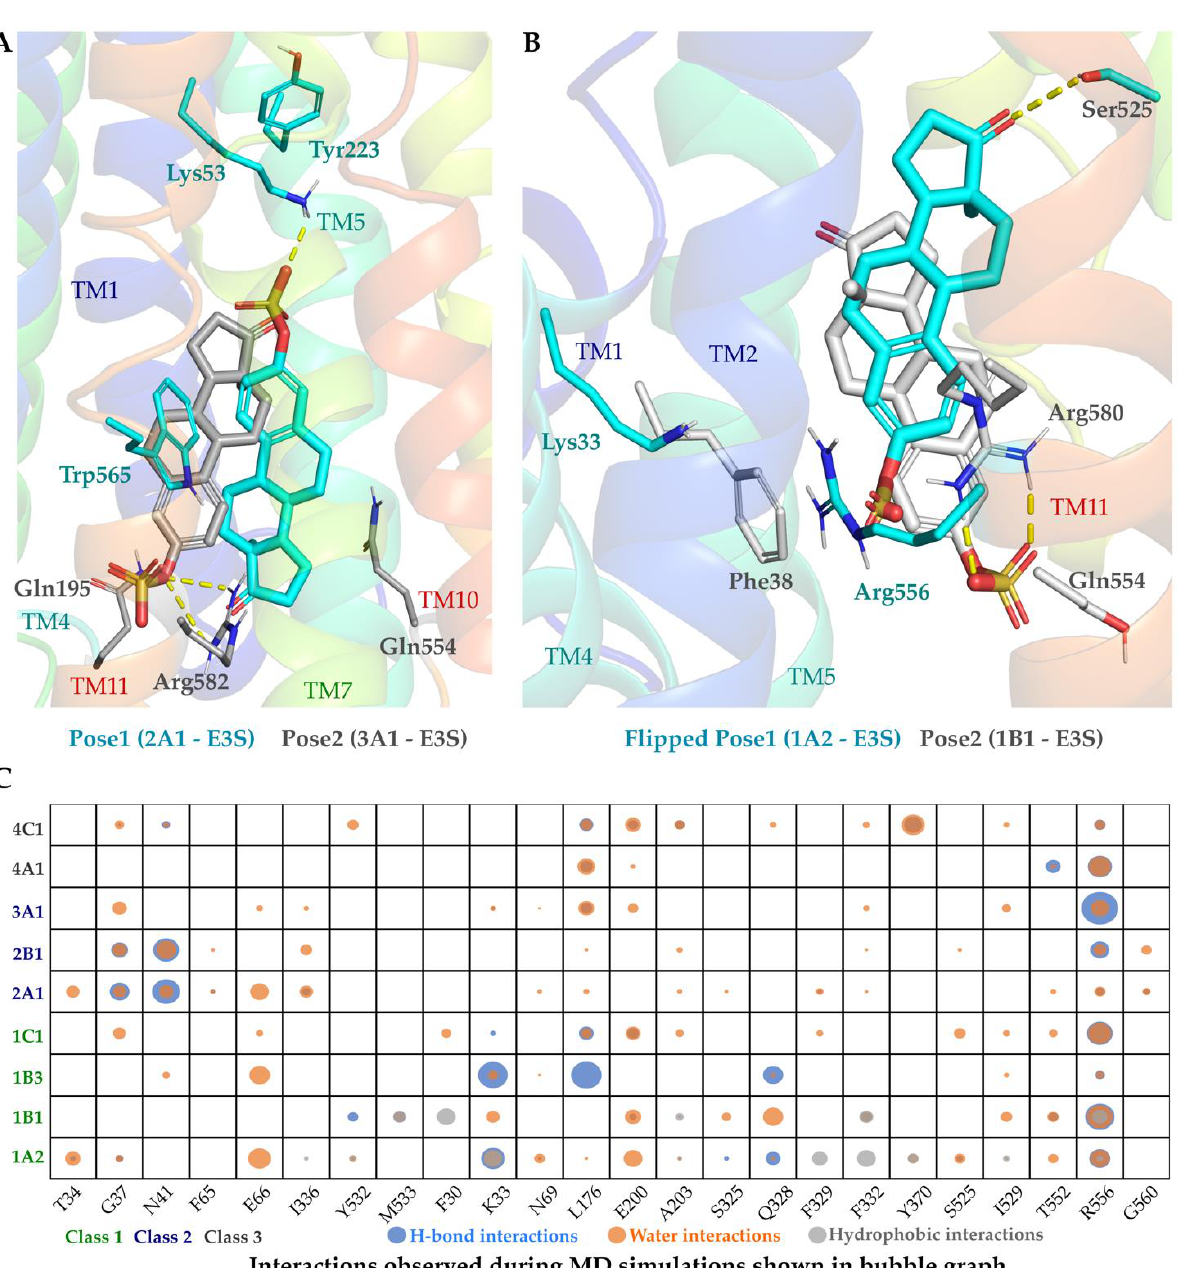
Figure 5. ( A ) Representative binding poses depicting Pose1 (OATP2A1) and Pose 2 (OATP3A1) observed in the docking. ( B ) Binding pose flip observed in OATP1A2 (Cyan) compared to OATP1B1 (grey) where there is a change from Pose1 to Pose2. ( C ) Frequency of protein – ligand interactions along the molecular dynamics simulation trajectories are shown in bubble graph; the residues are named according to OATP1A2, and the corresponding aligned residues could be referred from Figure 3B. All the docking poses shown above are of E3S.